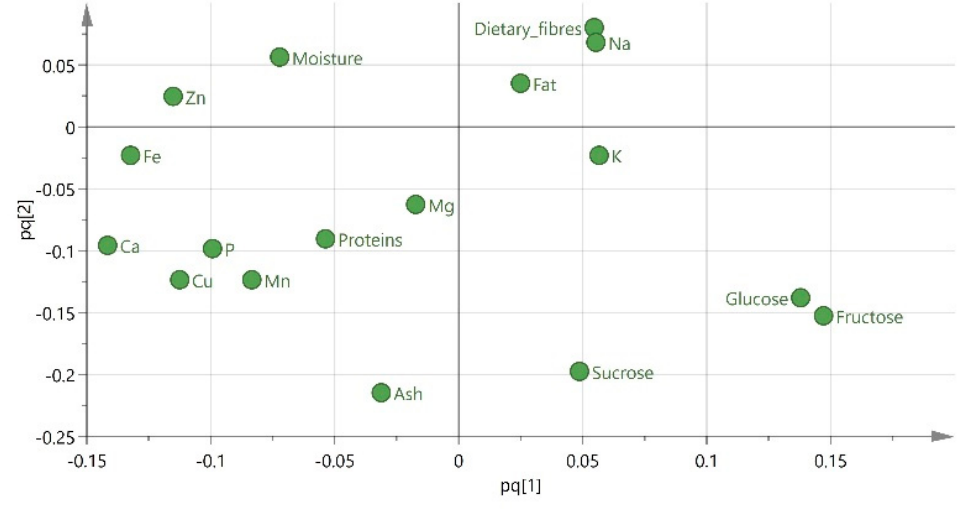
Figure 4. Loading score plot of the OPLS model.